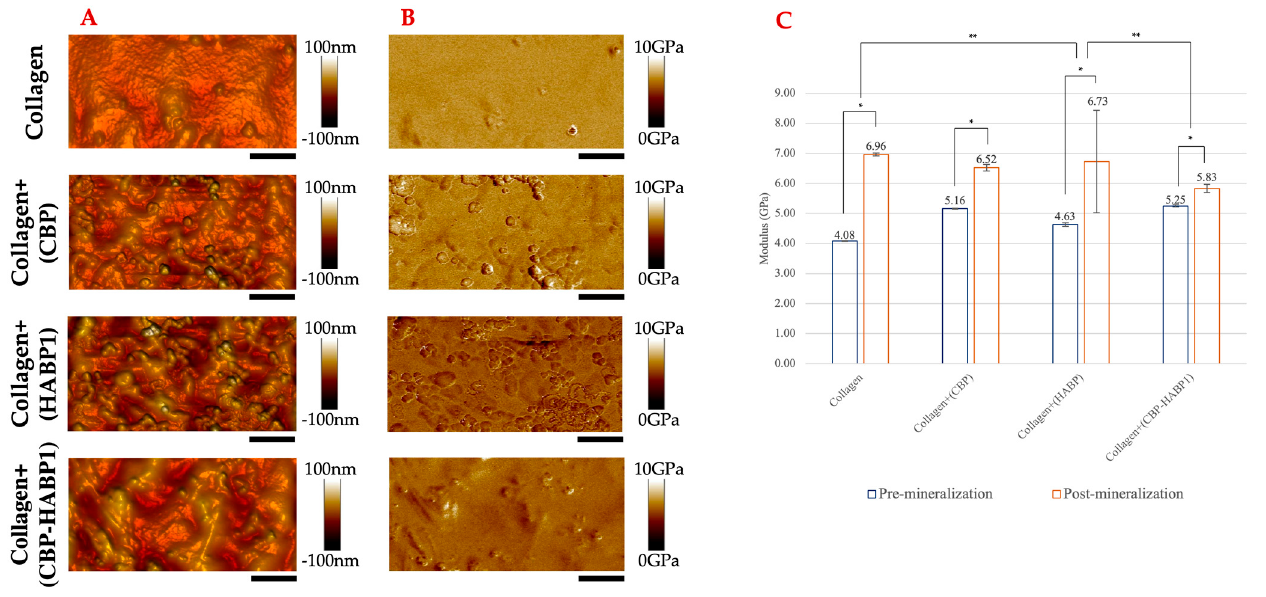
Figure 9. Characterization of peptide-functionalized collagen surfaces after 20 min of ALP-driven mineralization examined through PeakForce − QNM AFM. ( A ) AFM 3D-Topographical view. ( B ) Modulus mapping through the DMT modulus. ( C ) Comparison between pre- and post-mineralization per sample represented as averages over the area, error bars representing standard deviation, significant difference ( p < 0.05) is represented as *, **. Scale bar = 1 μ m.